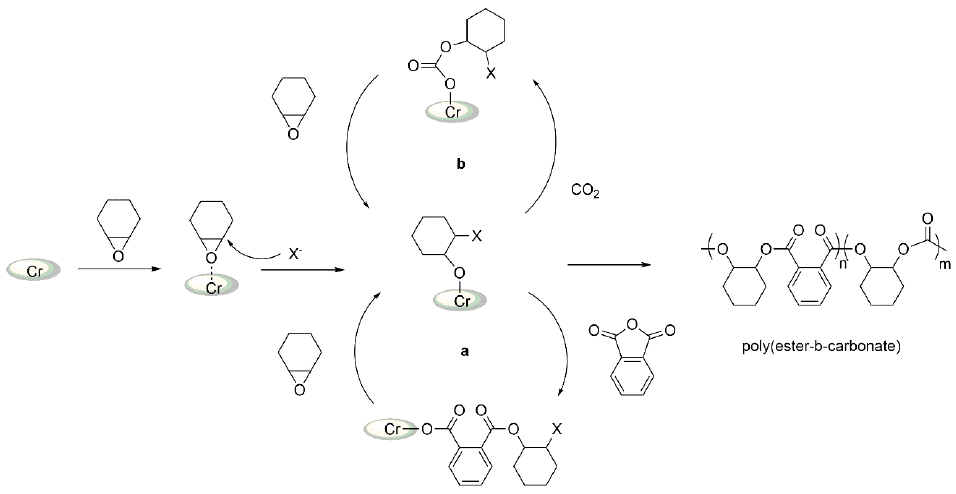
Scheme 4. Proposed mechanisms occurring during polymerization of cyclohexene oxide with CO 2 and/or phthalic anhydride.